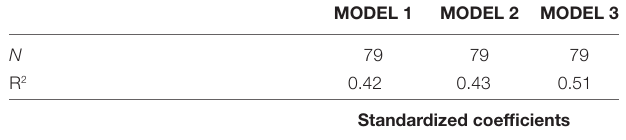
Table 1 | Standardized coefficients for linear regression models predicting average exam performance using the average time students spend reading per chapter and the average number of sessions students break their reading up into as predictor variables and controlling for pre-class physics knowledge (pre- semester